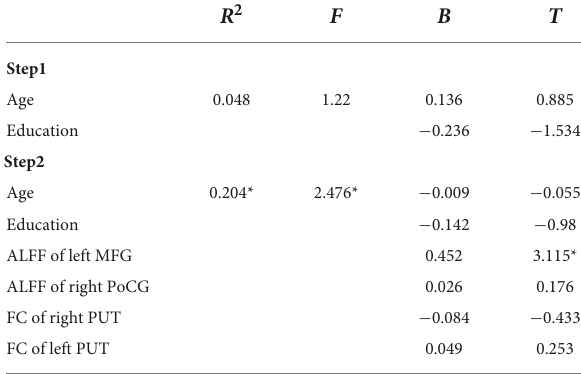
TABLE 7 Multiple linear regressions analyses between childhood trauma and brain